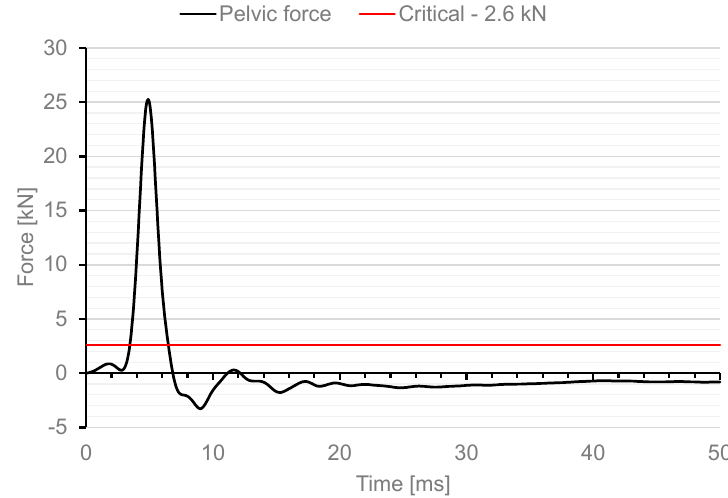
Figure 12. Characteristics of force change in a dummy pelvis after impact with an impactor.